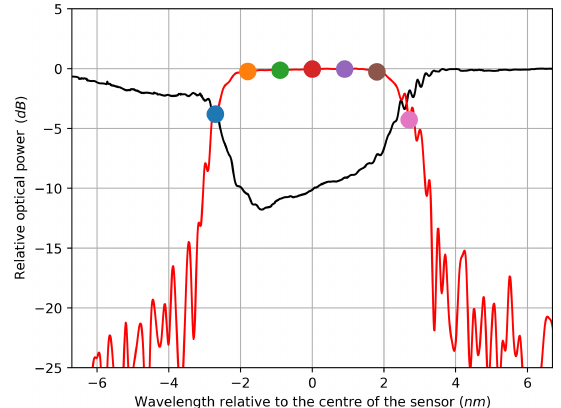
Figure 7. Electrically derived filter characteristic of an FBG in re- flection configuration (red) vs. optically derived filter characteristic of an FBG in transmission configuration